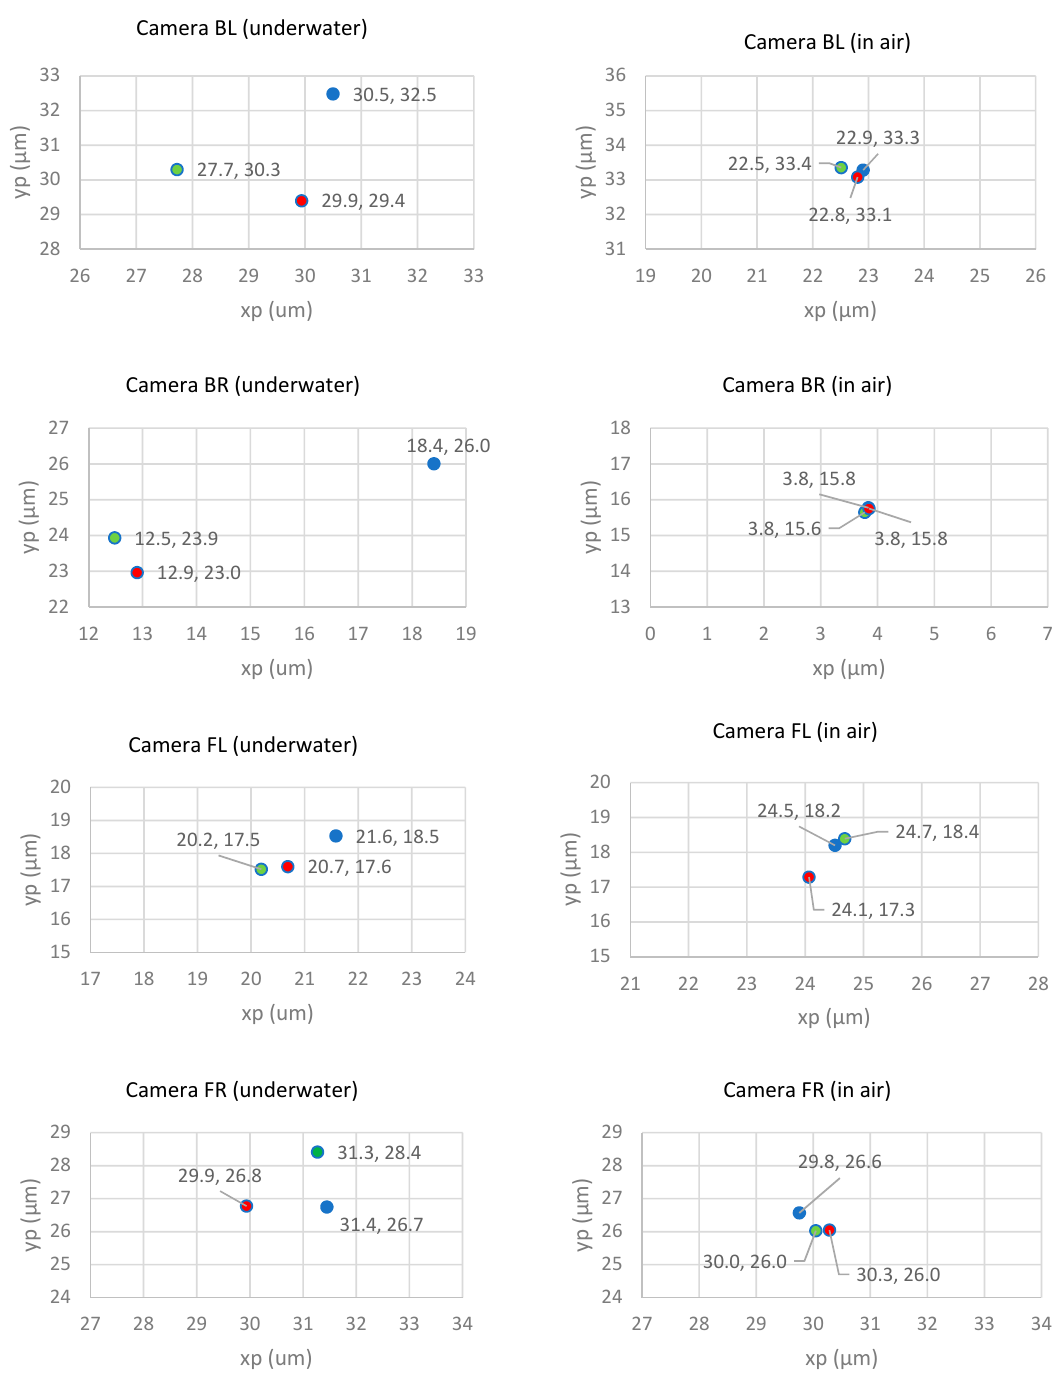
Figure 5. Comparison of the CMB calculated principal point o ff sets for the four di ff erent cameras (rows) in underwater ( left column) and in-air environment ( right column). The colours indicate the results for the di ff erent bands (blue, green,